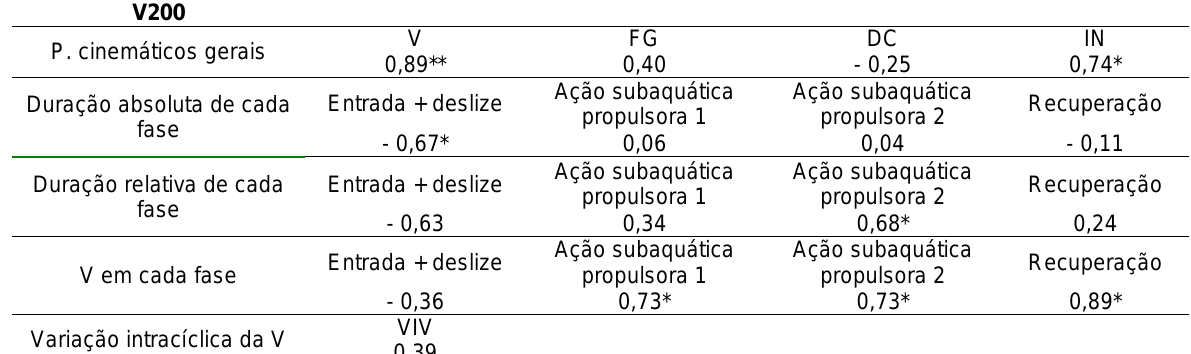
Tabela 1. Valores de coeficientes de correlação relativos à associação entre a prestação na prova máxima (V200) e as variáveis cinemáticas analisadas: velocidade de deslocamento do centro de massa (V), frequência gestual (FG), distância de ciclo (DC), o índice de nado (IN), duração absoluta de cada fase